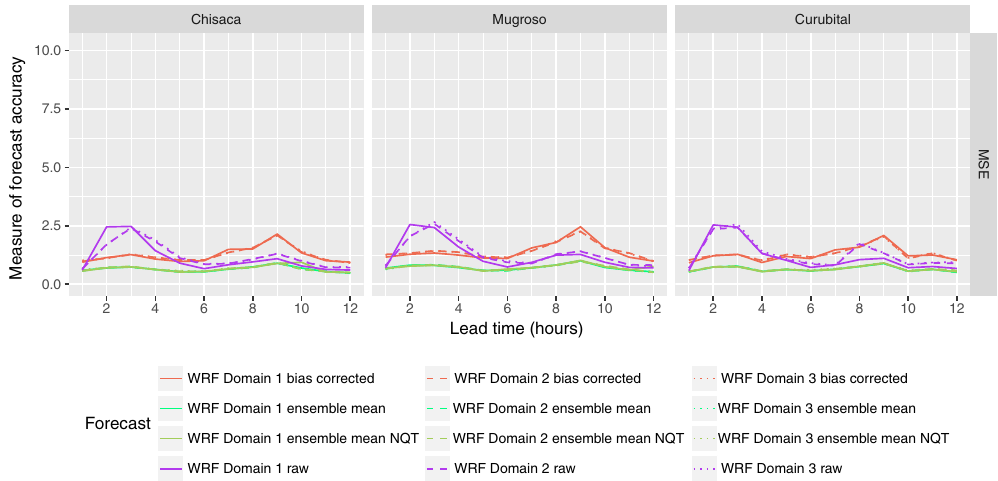
Figure 6. Accuracy measures for deterministic precipitation and ensemble mean obtained from the WRF model without the highest precip- itation missed by the WRF model. Domain 1, domain 2 and domain 3 correspond respectively to the domains with resolutions 15, 5 and 1.67km. The legend is the same as in Fig. 5.